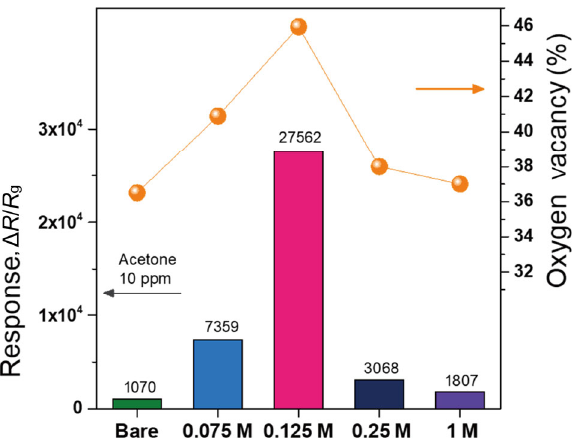
Fig. 8 Overall comparison of responses and fraction of oxygen